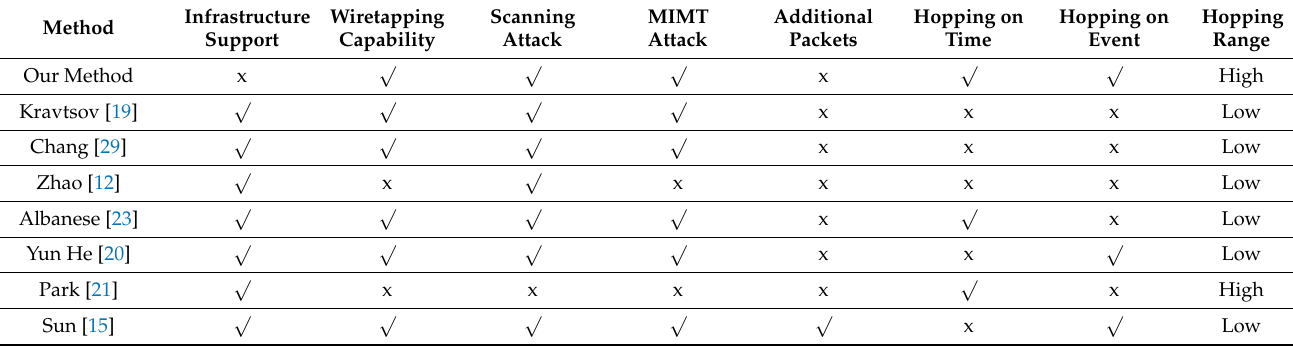
Table 3. Comparison of our algorithm and other IP hopping related methods.